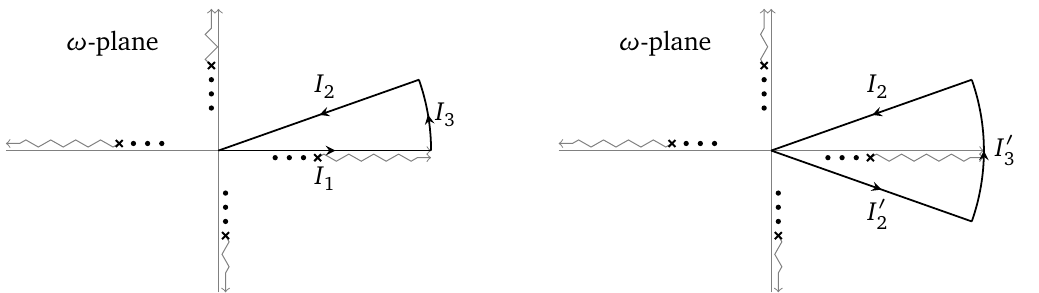
Figure 1: The analytic structure of the amplitude T ( ω , z ) on the complex ω